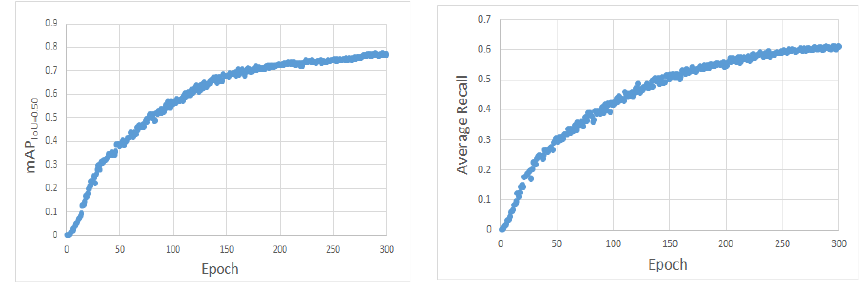
Figure 11. M-YOLOv3 mAP and AR trained on the TT100 dataset.